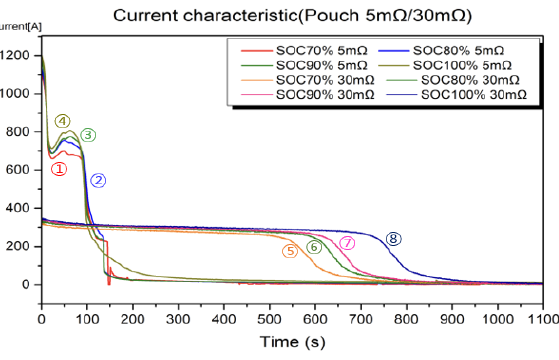
Figure 6. Current status of pouch cells during test with SOC and short-circuit resistance.